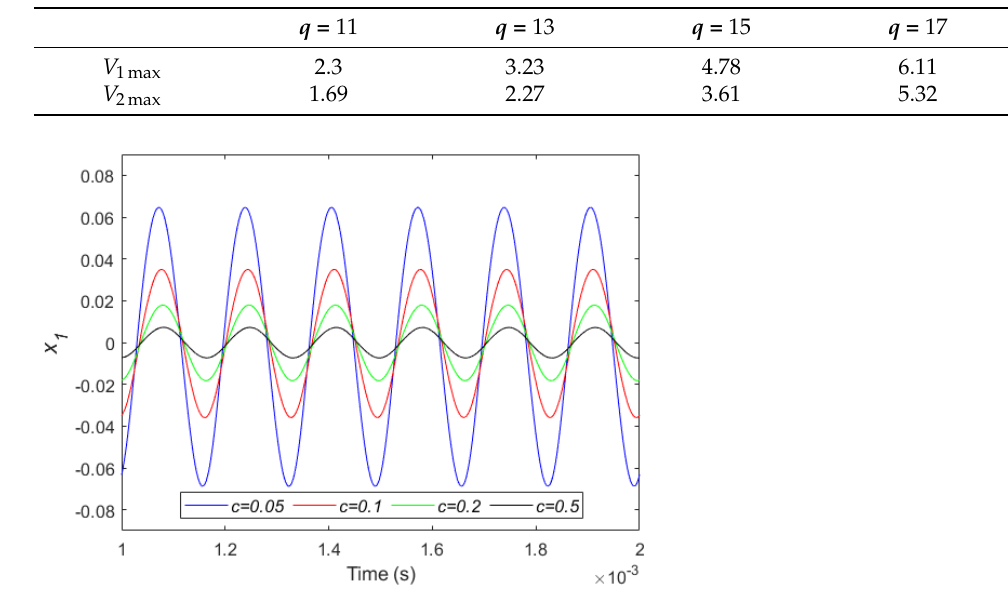
Table 1. The maximum applied voltages V 1 and V 2 for various amounts of q , p = 19, and β = 200.